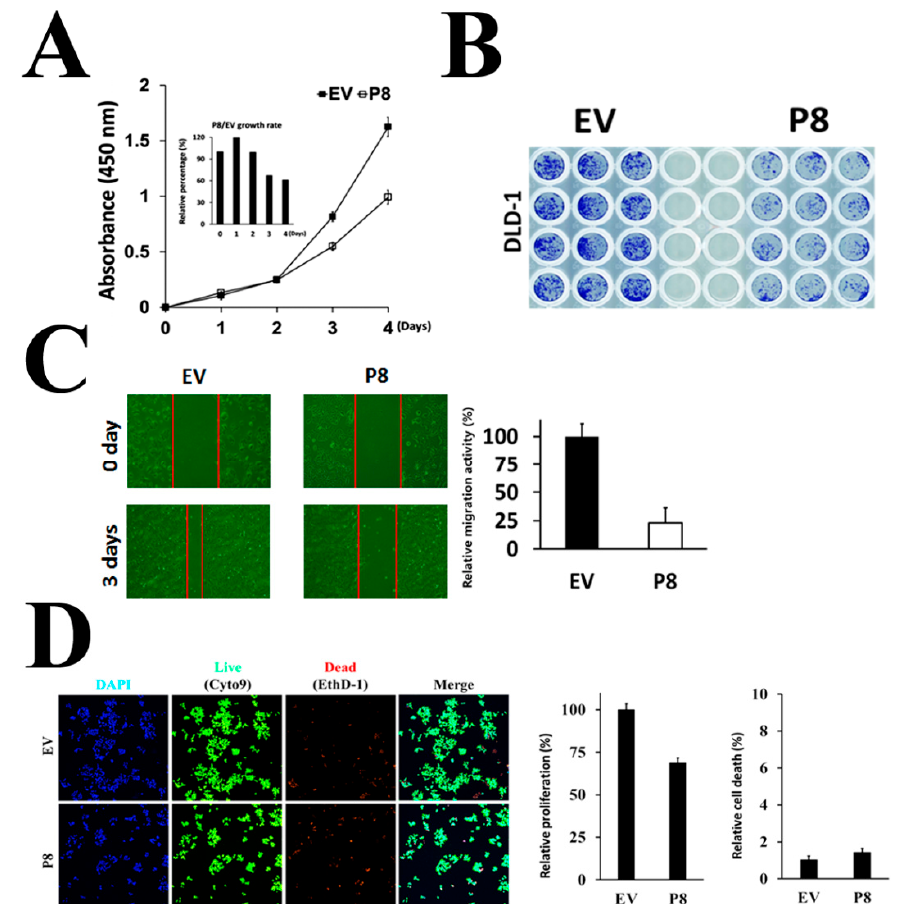
Figure 3. Endogenous p8 shows increased anti-cancer activity. ( A ) To examine whether endogenous expression improves the anti-cancer activity of endogenous p8 expression, we examined its anti-proliferative e ff ects in an MTT assay. ( B ) Colony formation after endogenous expression of p8 was determined by staining with crystal violet. ( C ) The anti-migration activity of endogenous p8 expression was determined in a wound healing assay. Wound recovery was analyzed using Image J. ( D ) Anti-cancer e ffi cacy of endogenous p8 expression was examined under an ImageXpress ® Micro Confocal microscope. Cells were stained with the live / dead cell markers Syto9 (Green) / EthD-1 (Red) or with the total cell marker Hoechst (Blue).